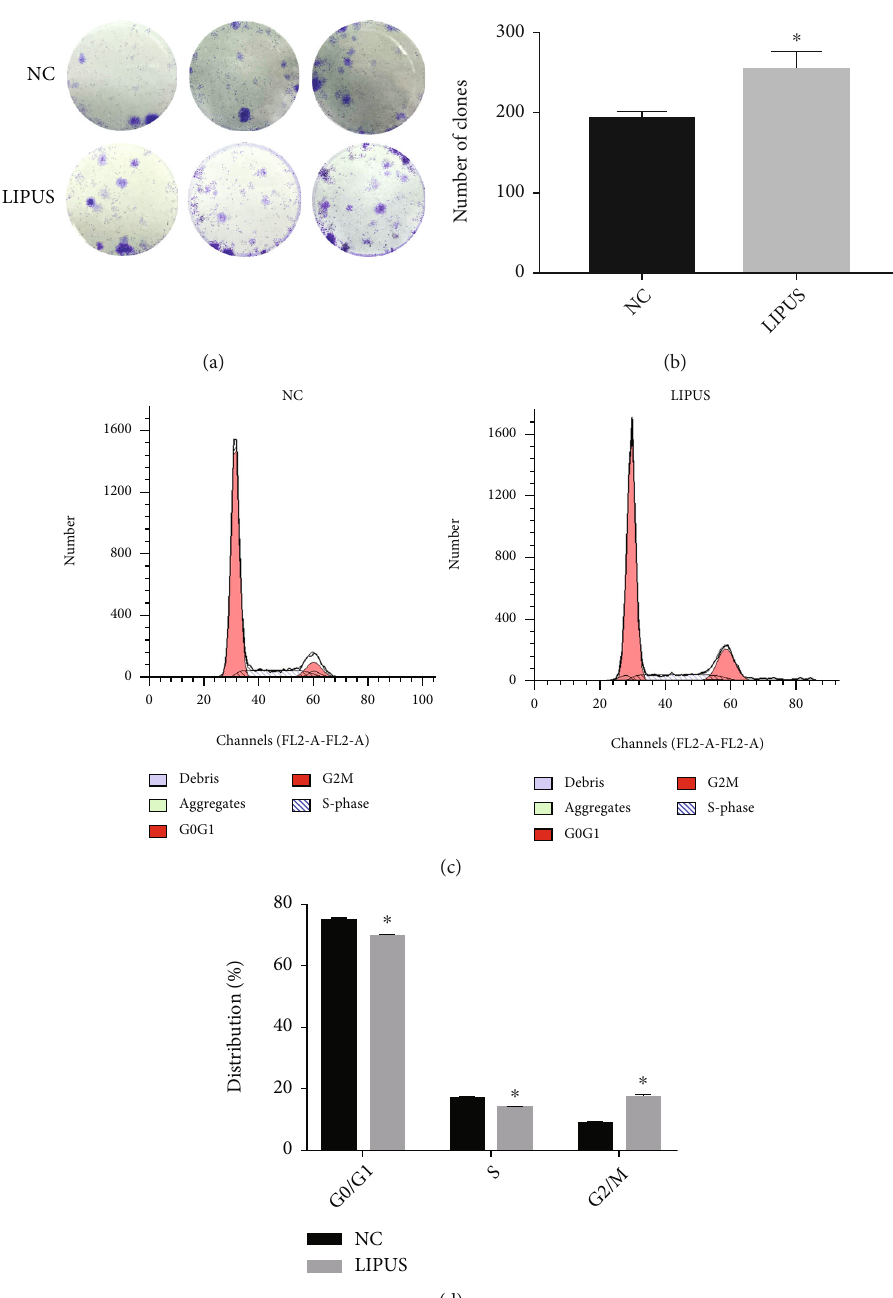
Figure 4: LIPUS promoted ADSC proliferation. (a), B Colony formation of ADSCs without and with LIPUS stimulation. (c), D The cell cycle distribution of ADSCs without and with LIPUS stimulation. Data are presented as the mean ± standard deviation. ∗ p < 0 : 05 when comparing the NC